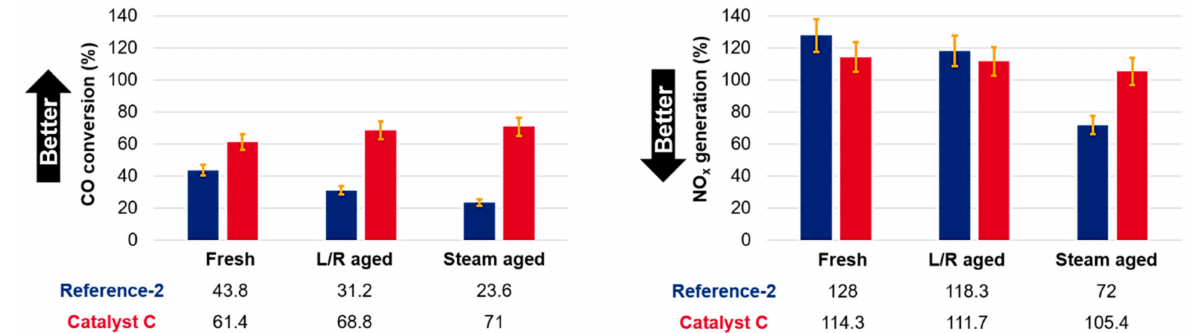
Figure 5. The activity of reference-2 and catalyst C in fresh as well as aged form for CO conversion and NO x generation are reported. The color-coding as well as the actual measured values are reported in the plots. Catalysts were tested by mixing 99% spent FCC catalyst and 1% fresh promoter using a plug flow reactor operating at 1 L/min flow rate with a feed of 2 vol.% O 2 in N 2 at 700 ◦ C. The emissions values determined by comparing to a promoter-free base case experiment. The method used to calculate CO conversion and NO x generation is reported in the experimental